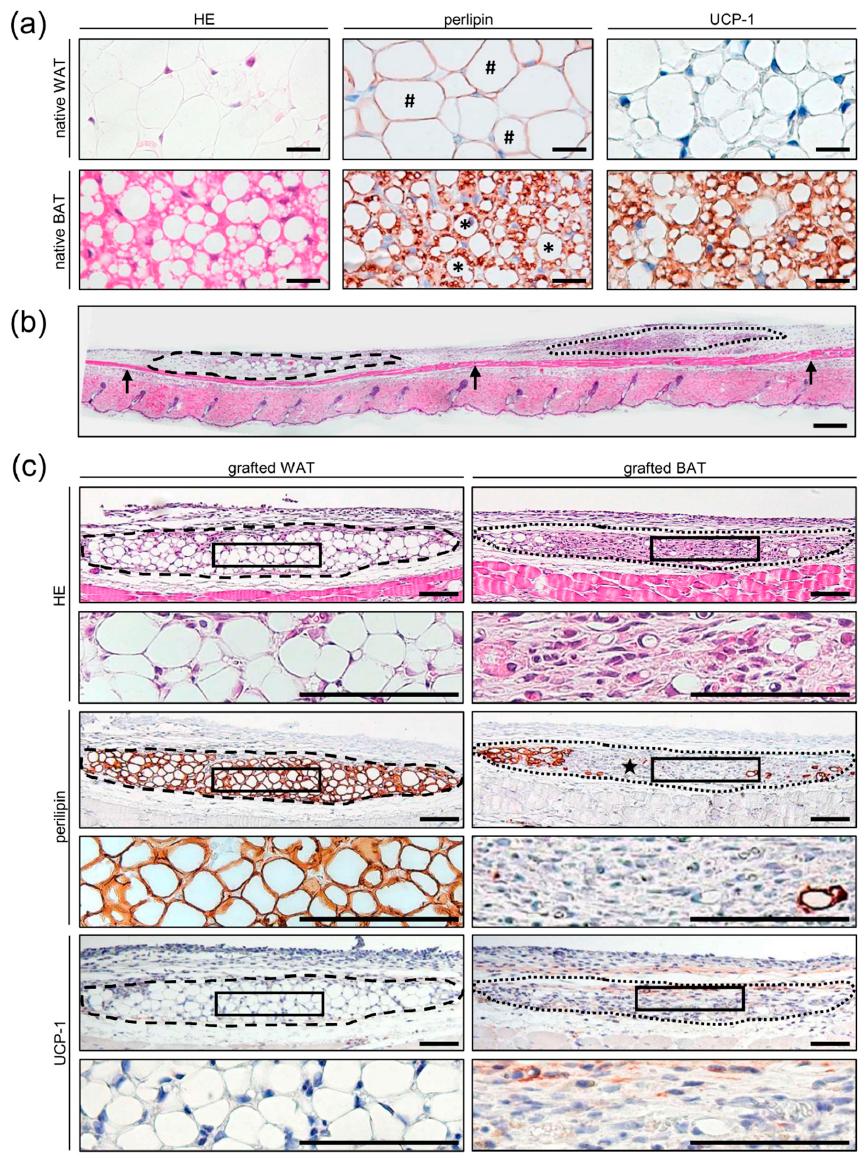
Figure 3. ( a ) HE-, perilipin-, and UCP-1-stained sections of native WAT and BAT. Note that native WAT consists of large white adipocytes (hashtags) with central fat reservoirs and peripheral nuclei. Native BAT is characterized by a high density of small brown adipocytes (asterisks) containing multiple lipid droplets and a dense, mitochondria-rich cytoplasm. In contrast to native BAT, no UCP-1 signal is detected in native WAT. Scale bars: 10 µ m ( b ) HE-stained section of a dorsal skinfold chamber preparation with a WAT graft (border marked by broken line) and a BAT graft (border marked by dotted line) located on top of the panniculus carnosus muscle (arrows) on day 14 after transplantation. Scale bar: 100 µ m. ( c ) HE-, perilipin-, and UCP-1-stained WAT and BAT graft sections on day 14 after transplantation. Note that the WAT graft exhibits an intact tissue architecture, whereas the BAT graft contains large areas of unspecific granulation tissue (star) in its center and only a few remaining perilipin-positive adipocytes in its border regions. Moreover, the BAT graft no longer exhibits a ubiquitous UCP-1 signal as a clear sign of brown adipocyte regression. Higher magnifications of inserts (border marked with black line) beneath the respective images. Scale bars: 50 µ